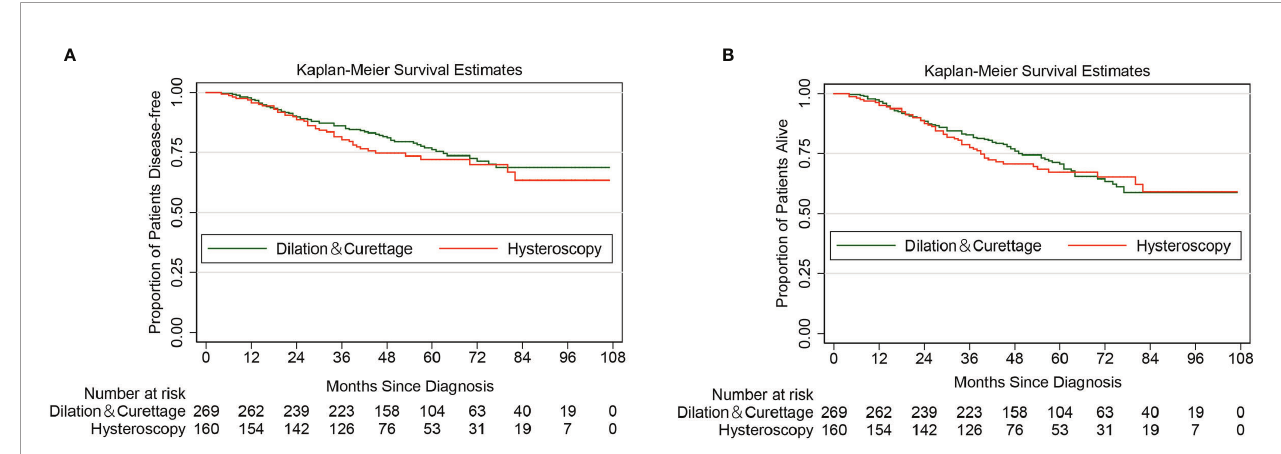
FIGURE 2 | Kaplan-Meier curves of disease-free survival and overall survival for patients with apparent early-stage type II endometrial cancer, by the methods of endometrial sampling. ( A for disease-free survival; B for overall